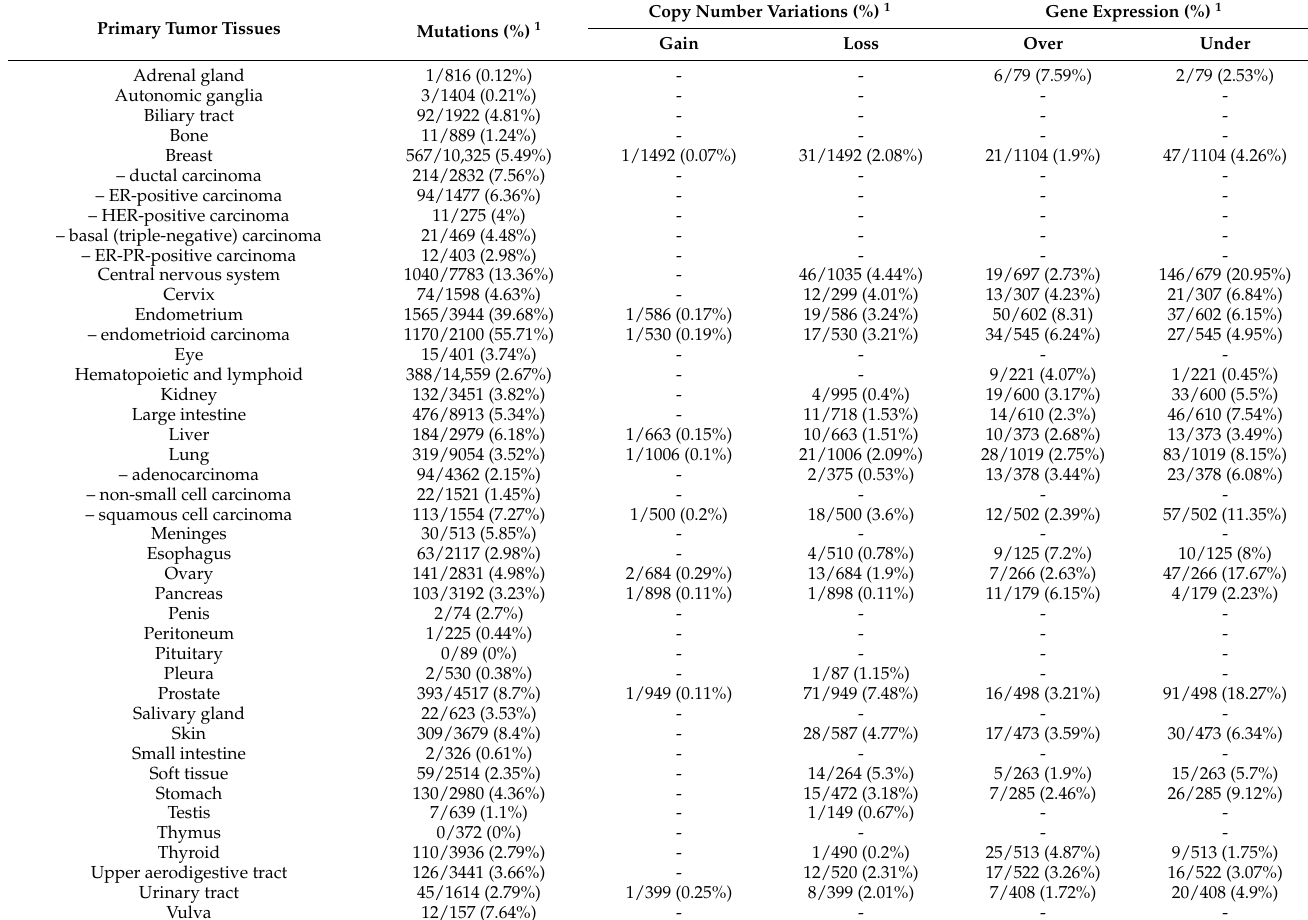
Table 4. Genetic alterations of PTEN in human